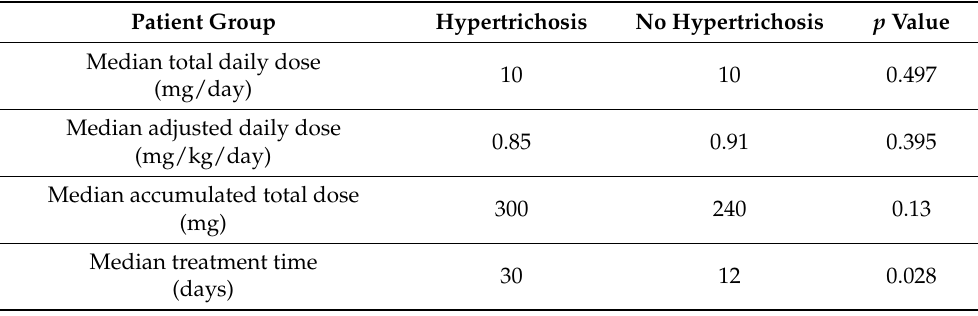
Table 2. Median values of the variables. Significant statistical differences were found in the median treatment time between hypertrichotic and no hypertrichotic